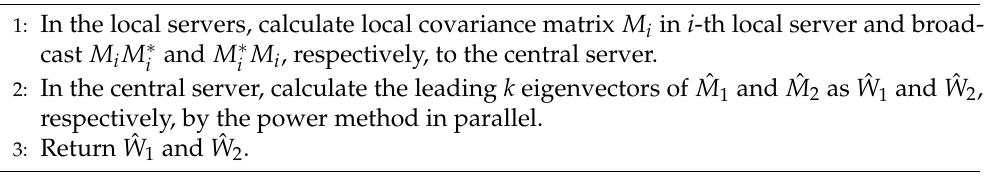
Algorithm 3 One-shot Distributed multiple CCA